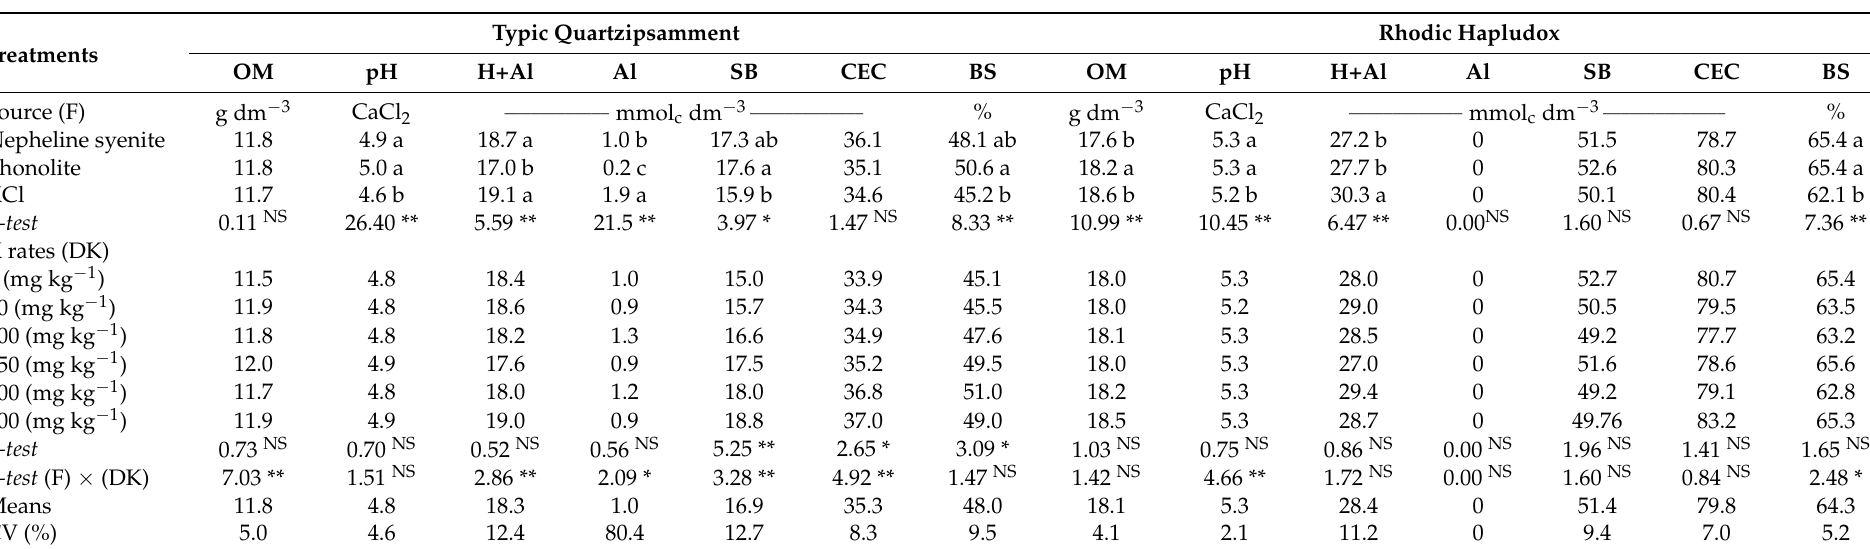
Table 3. Effects of treatments on some chemical attributes of the soil after maize cultivation in Typic Quartzipsamment, and in Rhodic Hapludox, depending on the application of sources and rates of